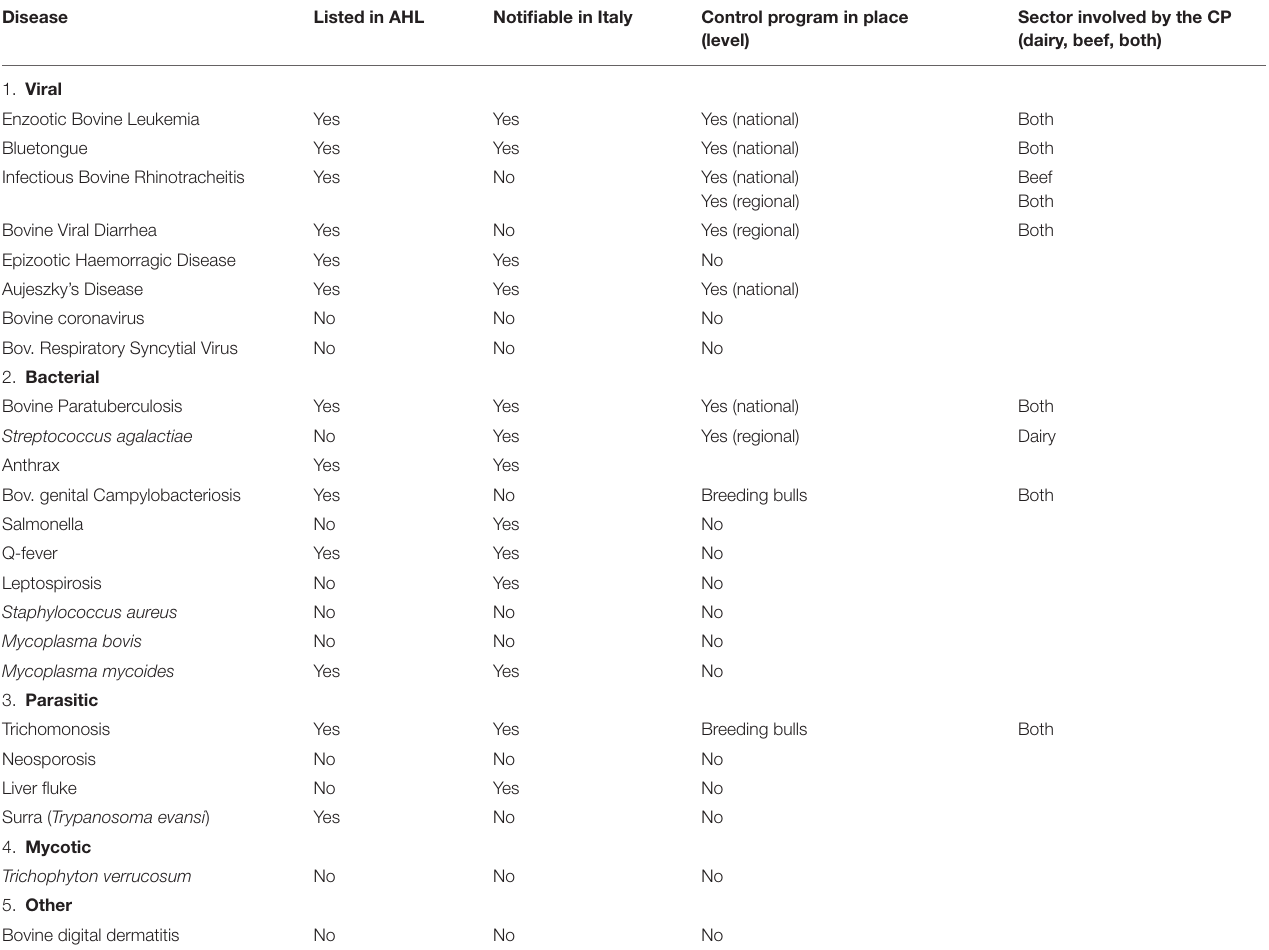
TABLE 8 | Presence of Control programs in Italy for 24 cattle diseases with little no EU regulations. Disease Listed in AHL Notifiable in Italy Control program in place